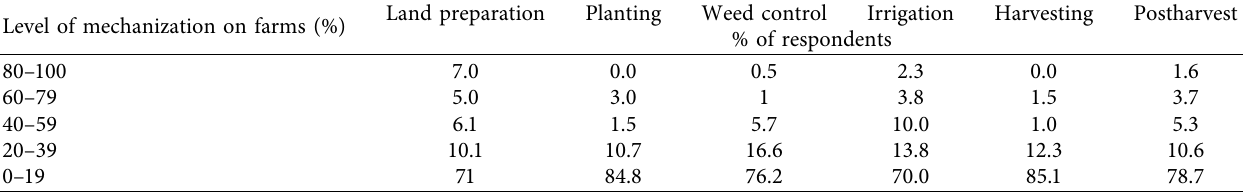
Table 4: Percentage of farmers with their rated level of mechanization on farms and its detailed mechanized farming operations. Level of mechanization on farms (%)